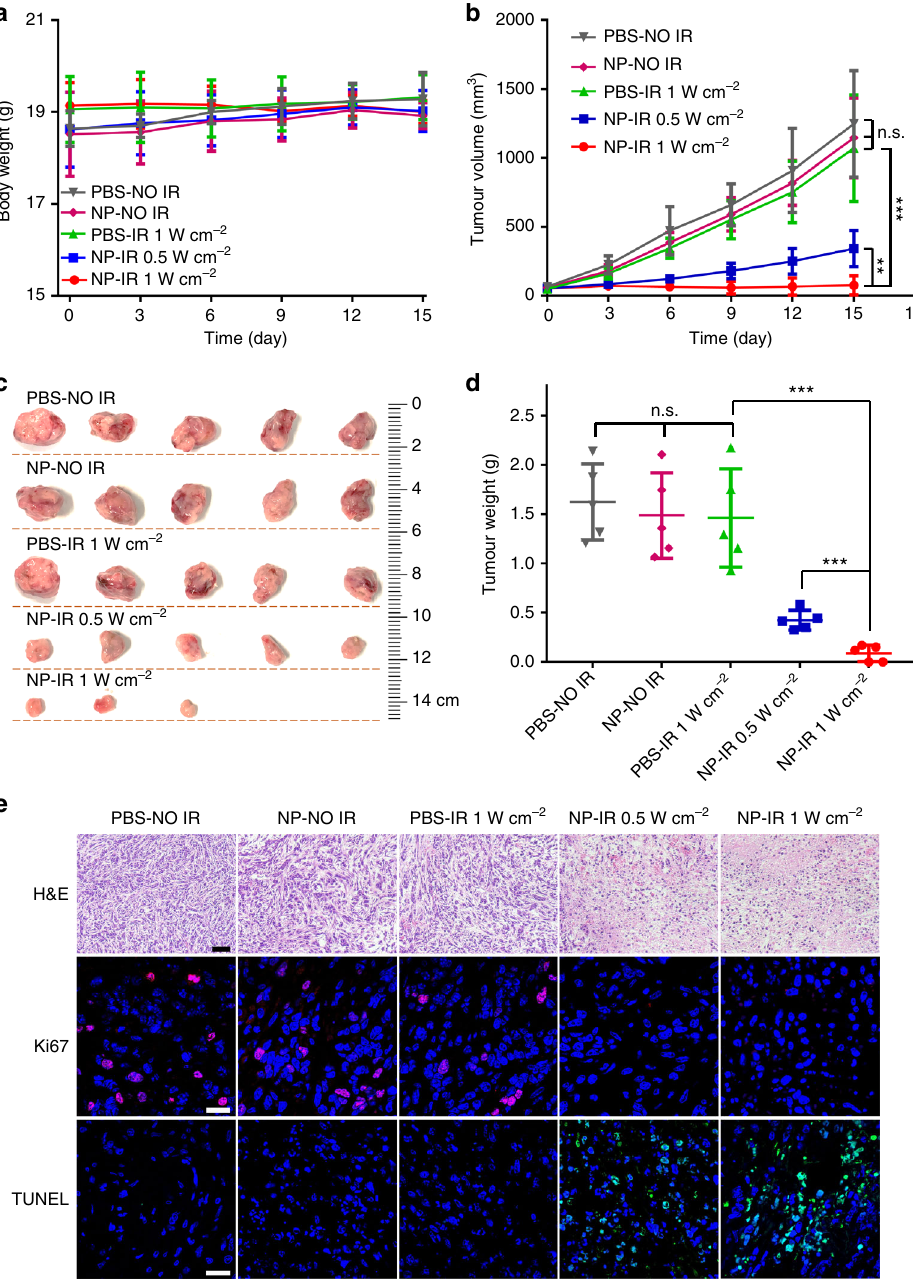
Fig. 5 PTT ef fi ciency of NP PPBBT nanopartiles on tumours. a , b Body weight ( a ) and tumour volume ( b ) curves of orthotopic EMT-6 tumour-bearing mice at different time points after receiving one dose of treatment with indicated formulations. At 24 h post injection, tumours were irradiated with (or w/o) laser for 10 min and the observations started. c , d Photographs ( c ) and weights ( d ) of tumours in mice sacri fi ced after 15-day observation. e H&E staining, Ki67 (Cy3, red) and DAPI (blue) counterstaining, and TUNEL (FITC, green) and DAPI (blue) counterstaining of the tumour tissues from mice sacri fi ced at day 15 post treatment. Scale bars, 50 μ m for H&E staining; 20 μ m for Ki67 and TUNEL staining. PBS-IR: PBS plus laser irradiation; NP-IR: NP PPBBT plus laser irradiation; NP-NO IR: NP PPBBT without laser irradiation. Results are presented as mean ± S.D., n = 5; n.s. not signi fi cant, p > 0.05; * p < 0.05; ** p < 0.01; *** p < 0.001, analyzed by Student ’ s t- light was determined by referring to the Fermi level ( E F = 0) of Au. To observe the spectra were recorded on a NanoBrook 90PLUS PALS particle size analyzer. Ele- ment contents were measured by an element analyzer (VarioELIII). secondary electron cutoffs of the conjugated polymers, a sample bias of − 10V was used. The difference between the width of whole valence-band spectrum and the photon energy of each material was used to determine its work function ( Φ ). Ultraviolet photoemission spectroscopy experiments . The ultraviolet photo- emission spectroscopy (UPS) examinations on the conjugated polymers were con- Synthesis of 2,5-dihexyl-1,4-dicyanobenzene . A solution of 1,4-dibromo-2,5- ducted at the photoemission end-station of BL10B beamline of the National diethylbenzene (87 mg, 0.3mmol) and CuCN (81mg, 0.9mmol) was re fl uxed in N, Synchrotron Radiation Laboratory (NSRL) in Hefei, China. The valence-band spectra N ′ -dimethylformamide (DMF, 2mL) for 24 h under nitrogen. The reaction mix- of the conjugated polymers were obtained when the materials were excited by the ture was poured into a saturated solution of NH 4 OH yielding a brown precipitate. synchrotron-radiation light a photon energy of 169.02eV. Photon energy of the beam